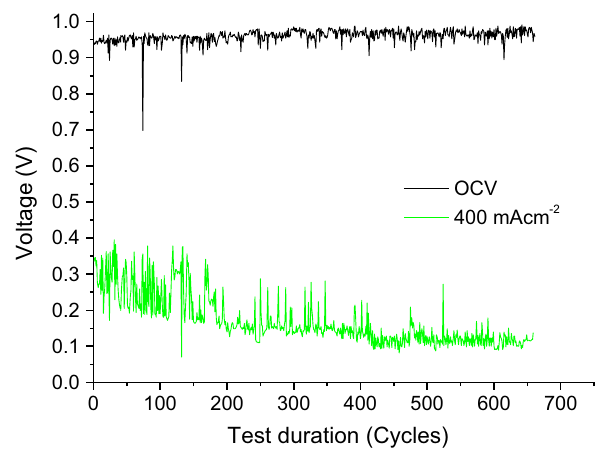
Fig. 3 Voltage evolution at OCV and 400 mA cm −2 during SU/SD cycling carried out between room temperature and 60 °C for 600 cycles at 100% RH, atmospheric pressure and stoichiometric ratio of